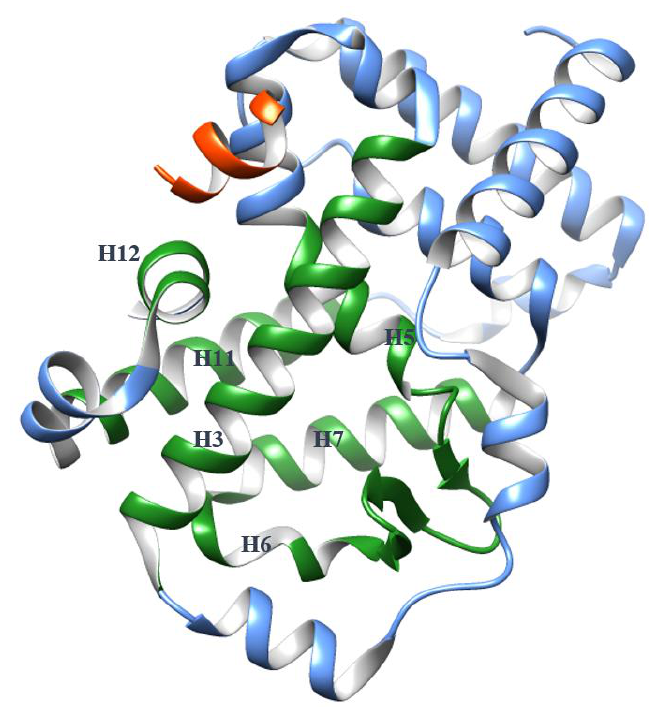
Figure 1. The globular structure of the apo RORγ ligand-binding domain (LBD) (Protein Data Bank (PDB) 5X8U) with a coactivator (orange). H3, H5, H6, H7, H11 and H12 are presented in green color to indicate the orthosteric binding pocket, while other helices are presented in blue color.